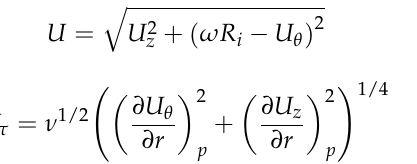
OneEqEddy model of OpenFOAM. model of